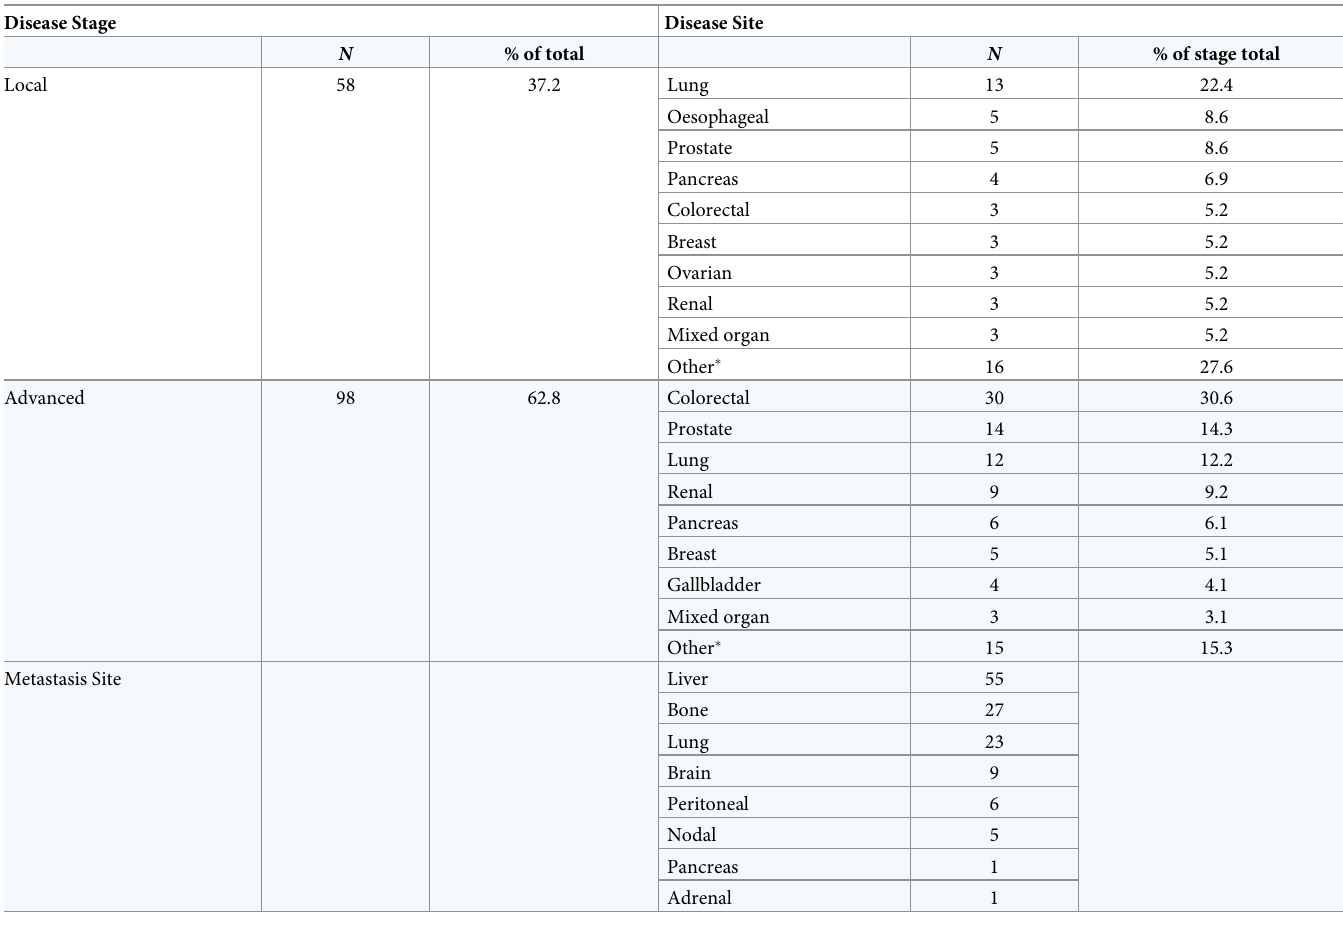
Table 3. Cancer stage, site and site of metastasis amongst all cancer patients in both main and validation cohorts